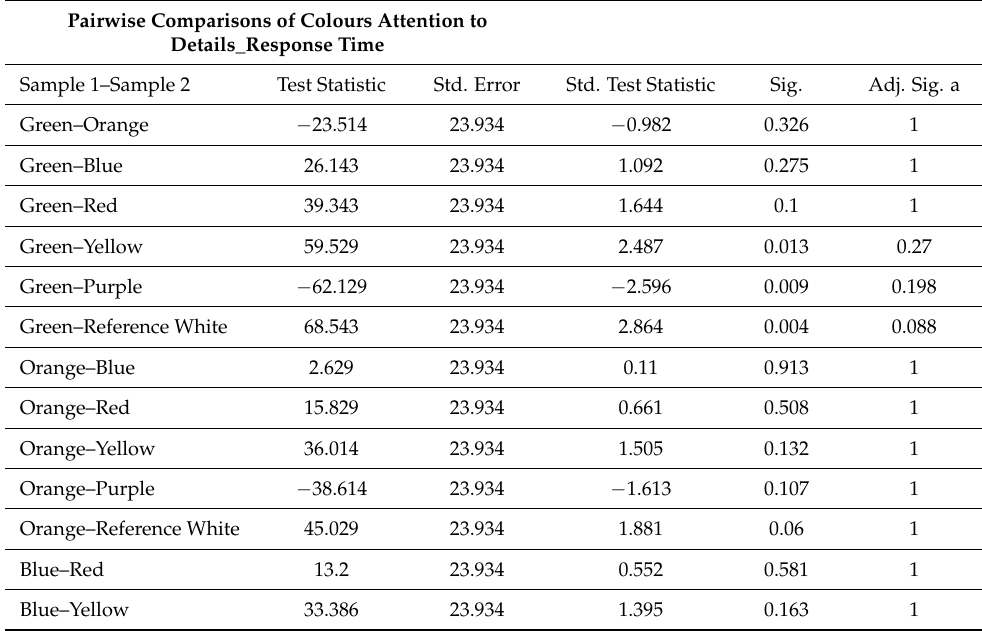
Table A17. Effects on response time (attention to